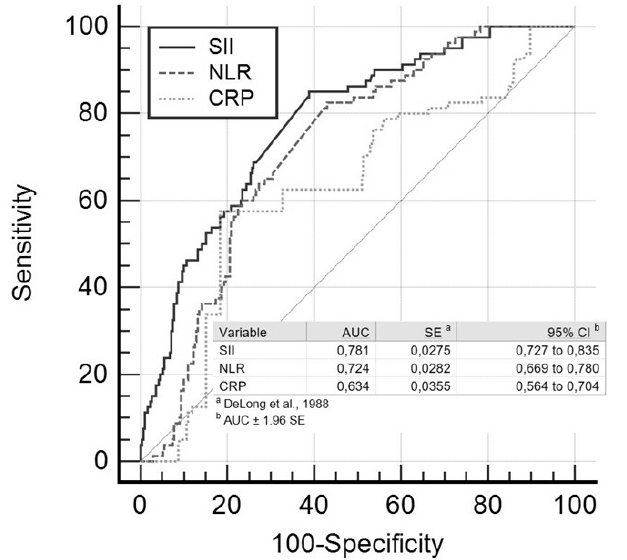
Fig. 1 - Effect of systemic immune-inflammation index (SII), neutrophil/lymphocyte ratio (NLR), and C-reactive protein (CRP) values on new-onset atrial fibrillation after coronary artery bypass grafting (receiver operating characteristic analysis). AUC=area under the curve; CI=confidence interval; SE=standard Table 4. Demographic characteristics of the study populations (matched group from non-new-onset atrial fibrillation group). CABG AF+ AF- P -value